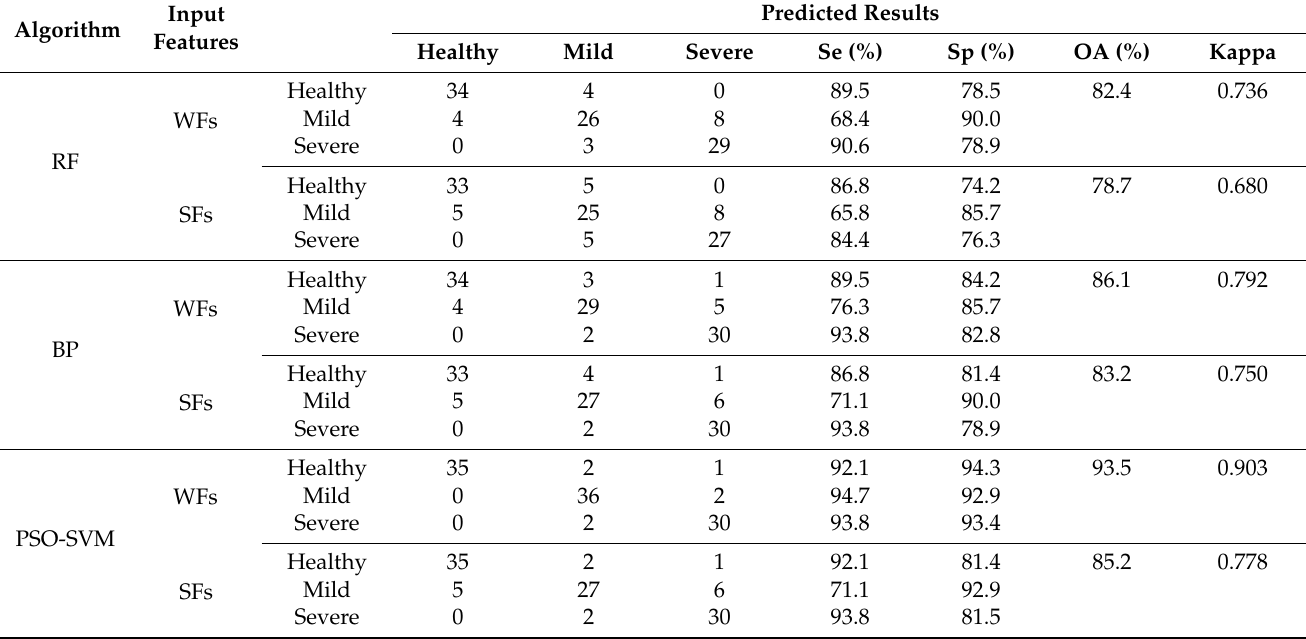
Table 4. Comparison of results of wheat FHB monitoring models constructed with different features and algorithms.